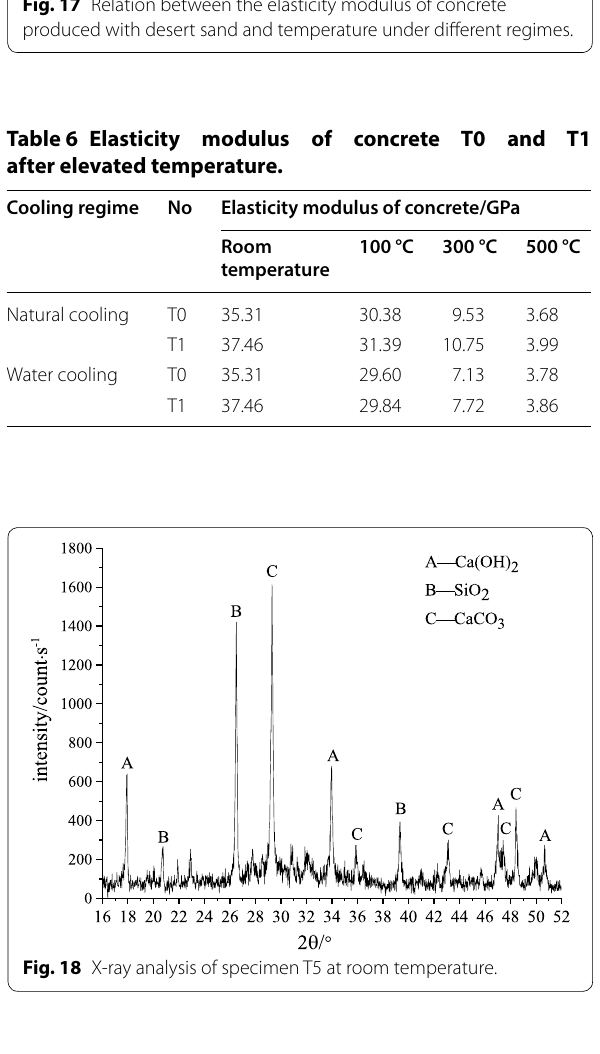
elasticity modulus of concrete produced with desert sand under the condition of water cooling was less than that under the condition of natural cooling.